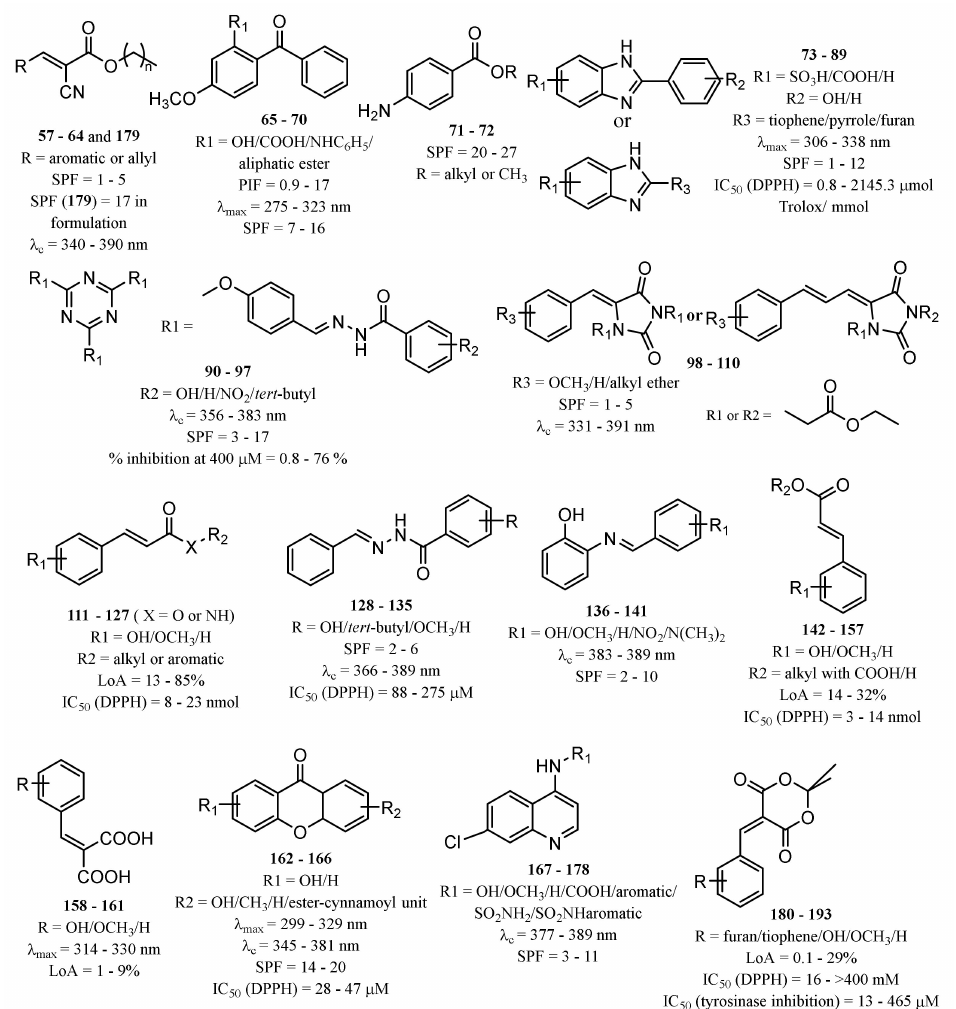
Figure 5. Chemical skeleton and values of biological activity assessed for the synthetic derivatives reported in the